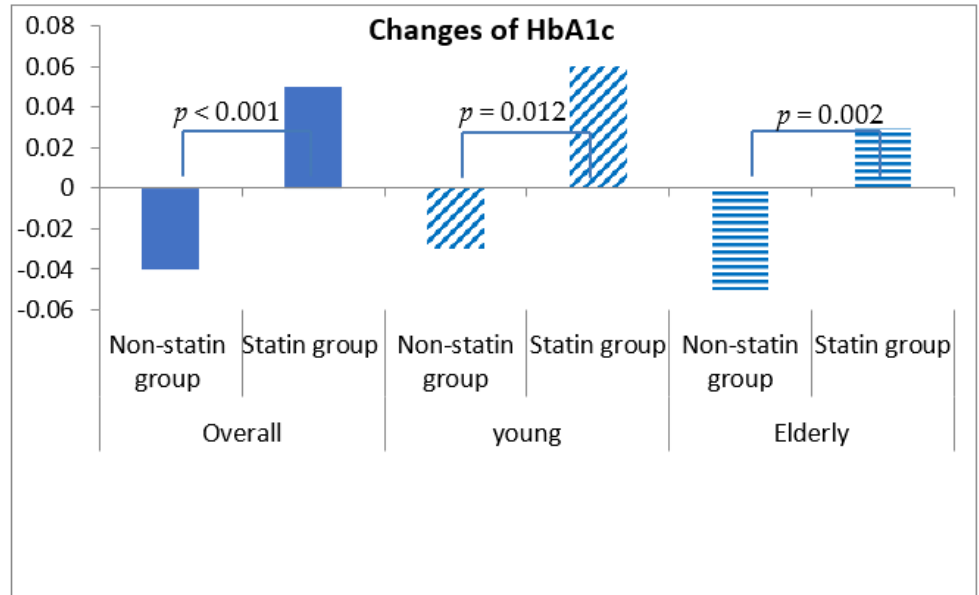
Figure 2. Changes in serum levels of HbA1c among non-statin and statin users overall and in young and elderly patients after propensity score matching.